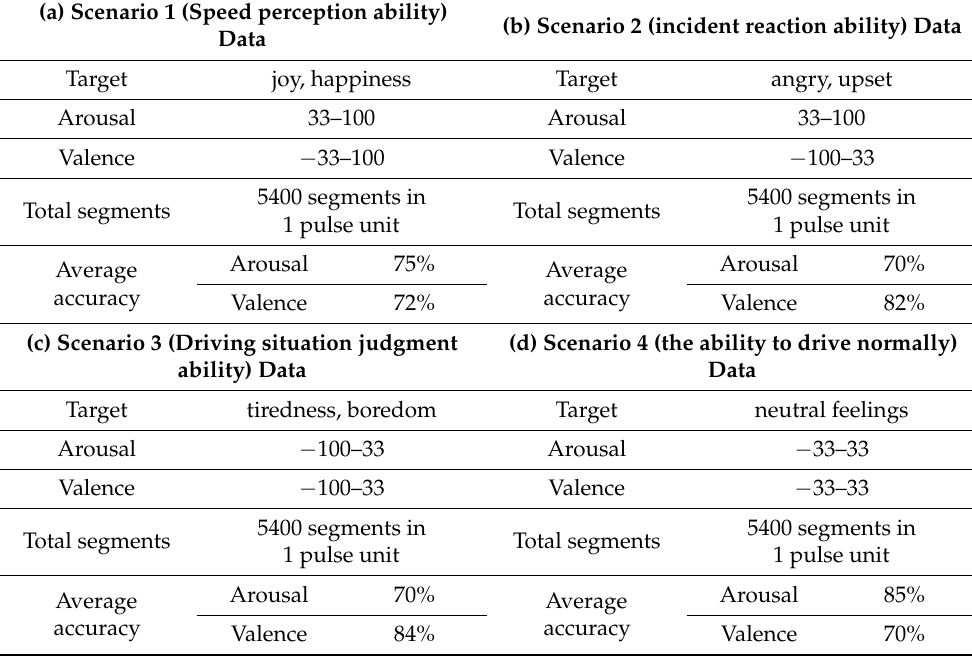
Figure 9. Experimental maps and data monitoring; ( a ) Route planning and simulator maps; ( b ) Rviz screen for vehicle monitoring. Table 3. Data composition and accuracy for each scenario used in the experiment .